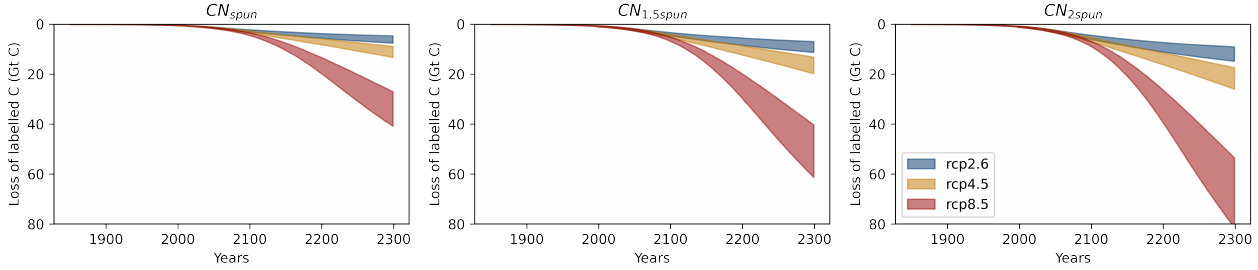
Figure A5. Permafrost carbon lost for the different model initialisation shown in Table